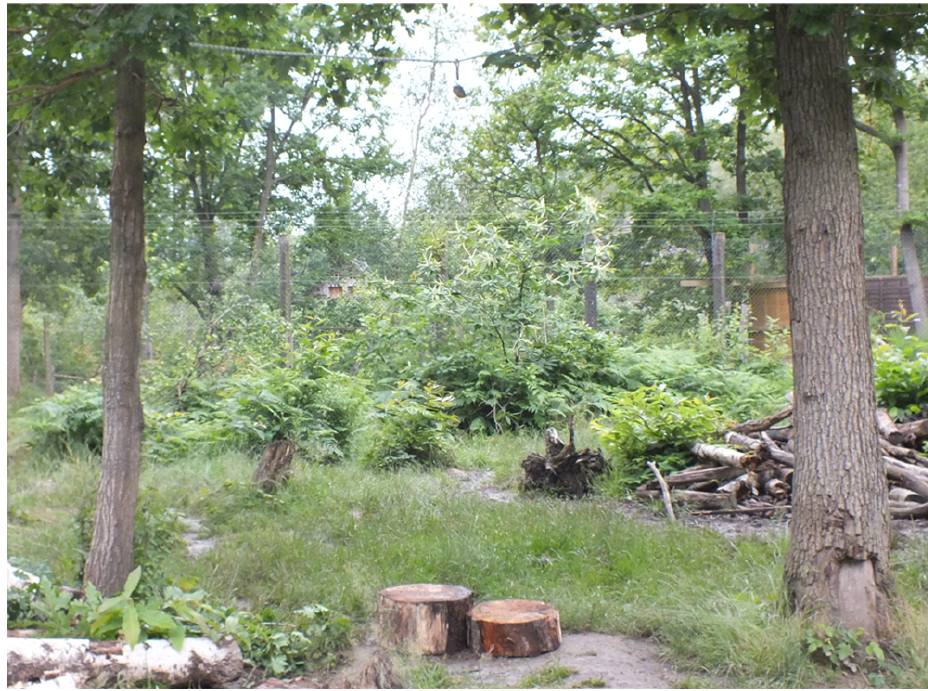
Object-Manipulation Set-Up: A Rope Secured Between Two Trees with a Food Item Hung in the Middle and Tree Stumps Provided Underneath. Photo credit: Chambers,